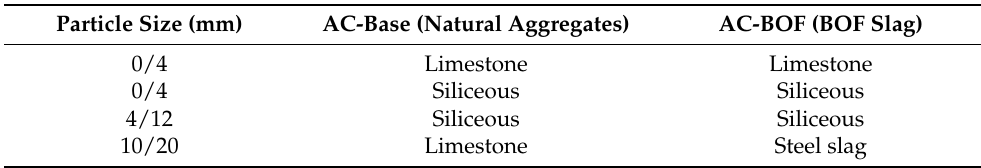
Table 1. Aggregates and particle size used in mix design (AC-Base: mix with natural aggregates; AC-BOF: mix with BOF